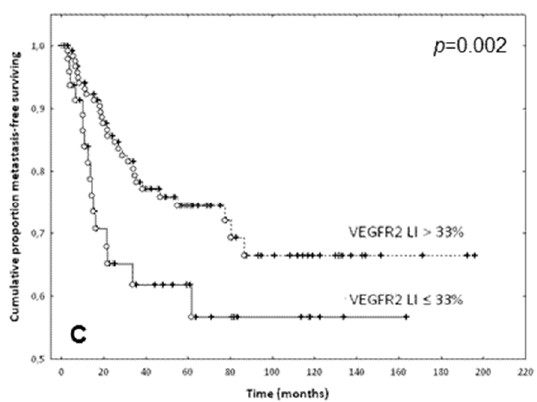
Figure 4. Prognostic value of VEGFR-1 and VEGFR-2 expression in EC of CRC: ( A ) Metastasis-free survival curves of patients dichotomized based on VEGFR-1 LI ≤ (solid line) or > (dotted line) 5% ( p = 0.063). ( B ) Overall survival curves of patients dichotomized based on VEGFR-1 LI ≤ (solid line) or > (dotted line) 5% ( p = 0.013). ( C ) Metastasis-free survival curves of patients dichotomized based on VEGFR-2 LI ≤ (solid line) or > (dotted line) 33% ( p = 0.002). Complete and censured data are shown as dots and crosses, respectively.